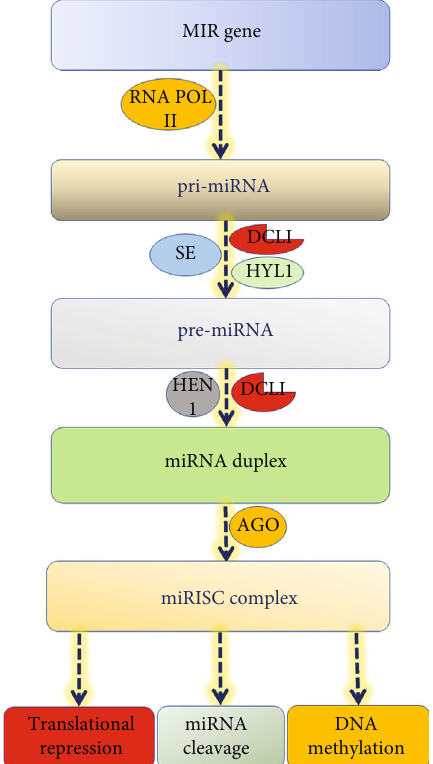
Figure 1: Schematic diagram depicting the biogenesis and mode of action of plant